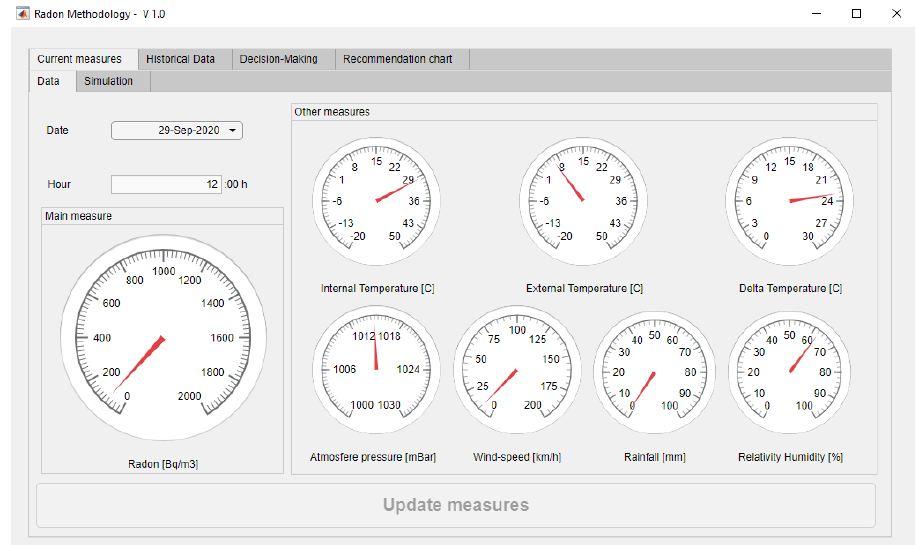
Figure 6. Dashboard for the visualization of the variables.